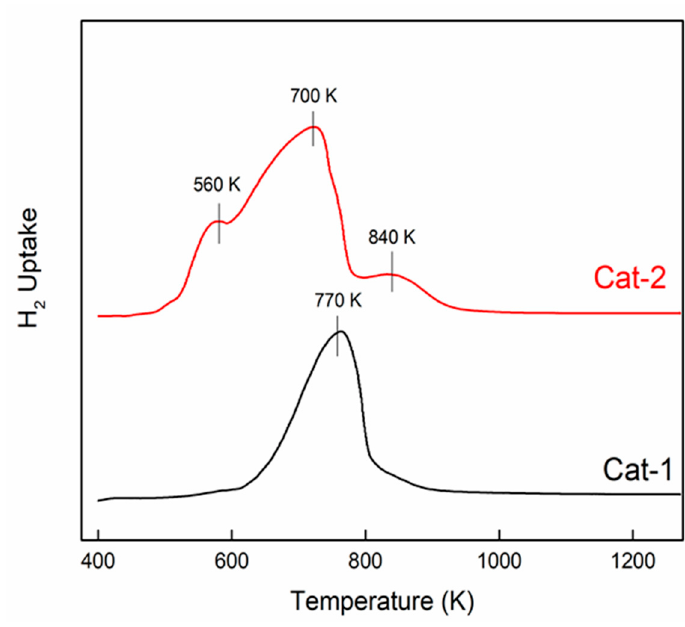
Figure 2. The temperature-programmed reduction for fresh catalyst.